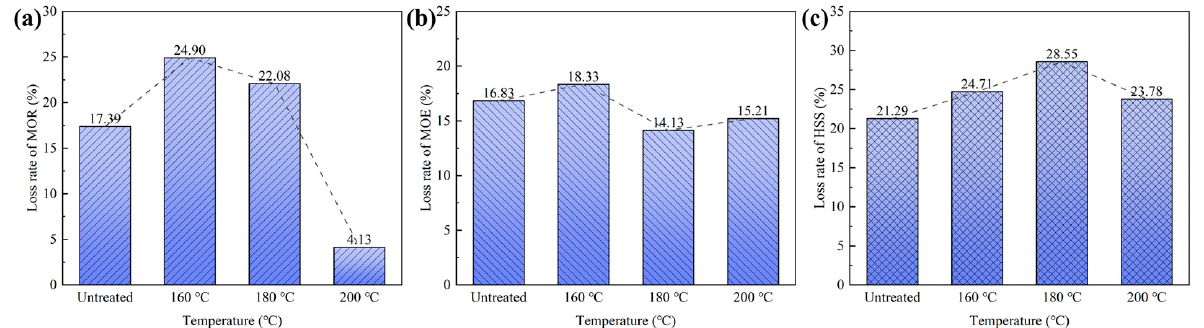
Figure 5. Loss rates of (a) MOR, (b) MOE and (c) HSS of bamboo scrimbers after the artificial weathering test.